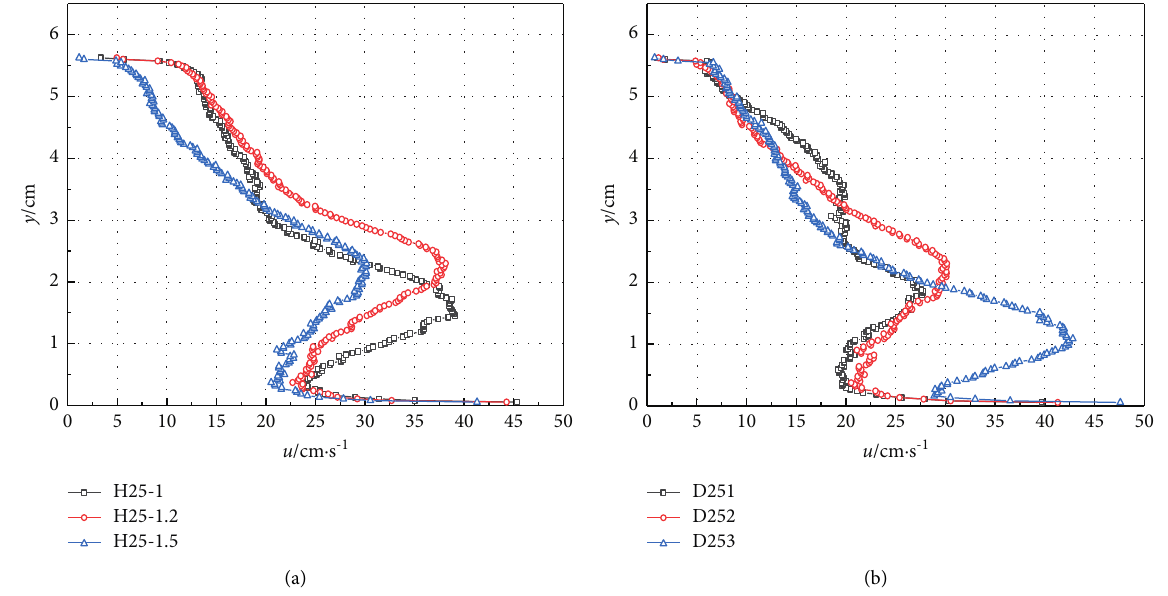
Figure 12: The vertical distribution of the lateral turbulent intensities in different working conditions ( x � 2cm).